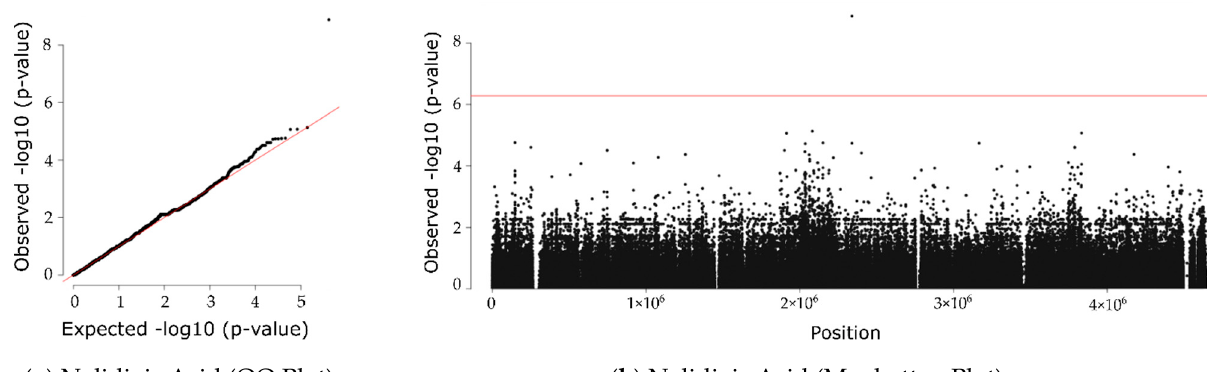
( g ) Nalidixic Acid (QQ Plot) ( h ) Nalidixic Acid (Manhattan Plot) Figure 4. GWAS analysis. Left: QQ plots of observed vs. expected p -values show a few highly significant p -values. Right: Manhattan plots of chromosomal position vs. p -value show mutations passing the Bonferroni-corrected threshold as dots above the red line.